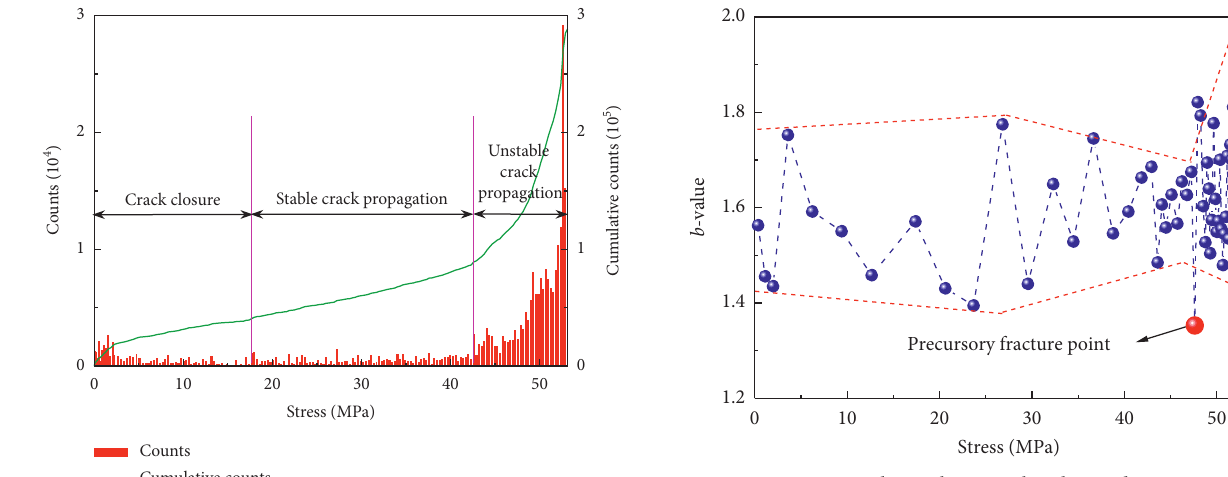
Figure 3: Relation between b value and stress.